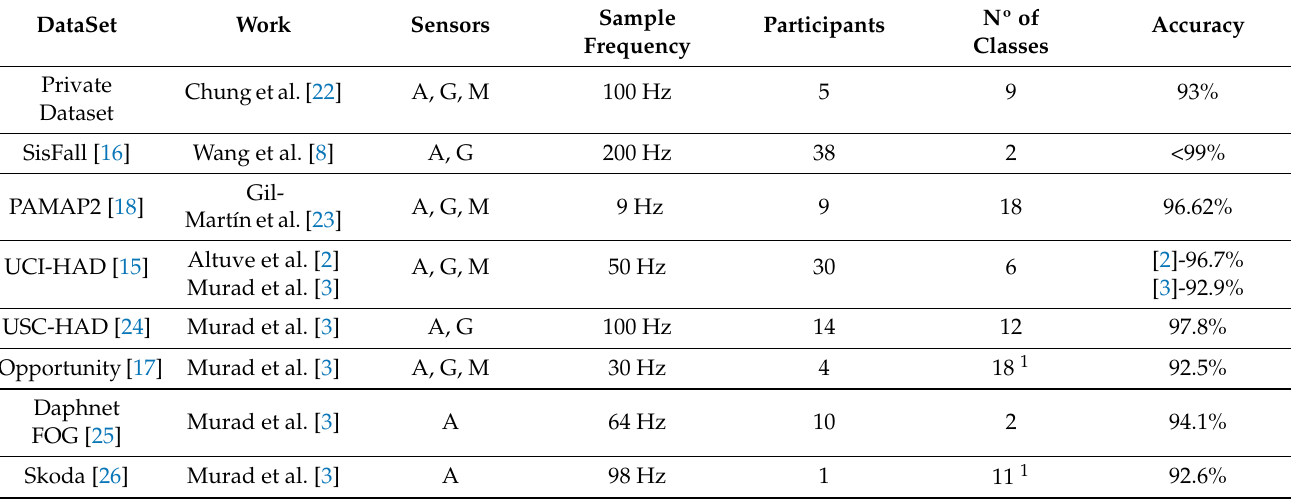
Table 1. Datasets used for the evaluation of the Deep Learning algorithms analyzed in the literature and respective description regarding sensing methods, sample frequency, participants, number of activities (classes) recorded and algorithm performance (accuracy). In this table: A =